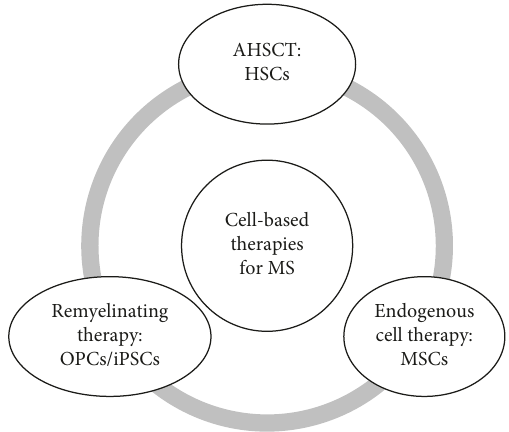
Figure 2: A schematic representation of cell-based therapies in multiple sclerosis. AHSCT: autologous hematopoietic stem cell